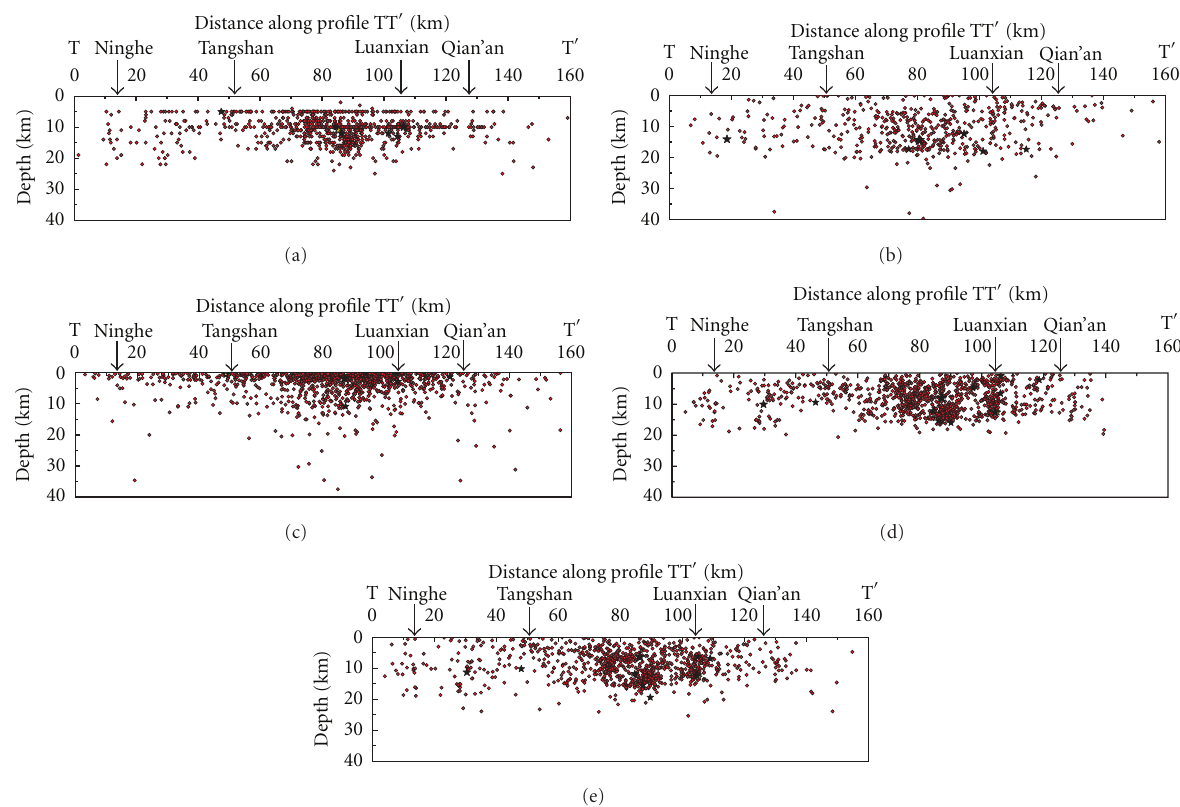
Figure 14: Cross-section of focal depth along the profile TT (cid:5) by various methods in the Tangshan area. Stars and circles show the earthquakes of M L ≥ 4.0 and M L < 4.0, respectively. (a) Distribution of focal depth by Capital Digital Seismic Network and North China Telemetry Seismic Network; (b) distribution of focal depth using local tomography with Thurber [1] method [2]; (c) distribution of focal depth using seismic tomography with Zhao et al. [3] method [4]; (d) distribution of focal depth using DD location method [5]; (e) distribution of focal depth using tomoDD method [6].